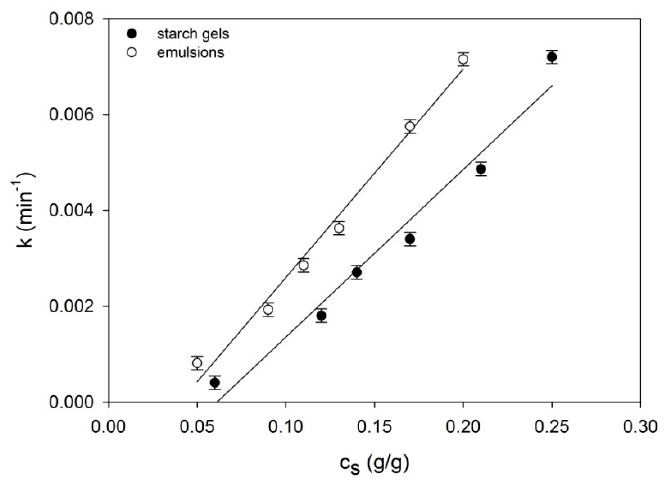
Figure 2. Concentrational relationships of the time constant k of the examined starch gels and starch-fat emulsions. The values are expressed as means ± SD ( n = 3).